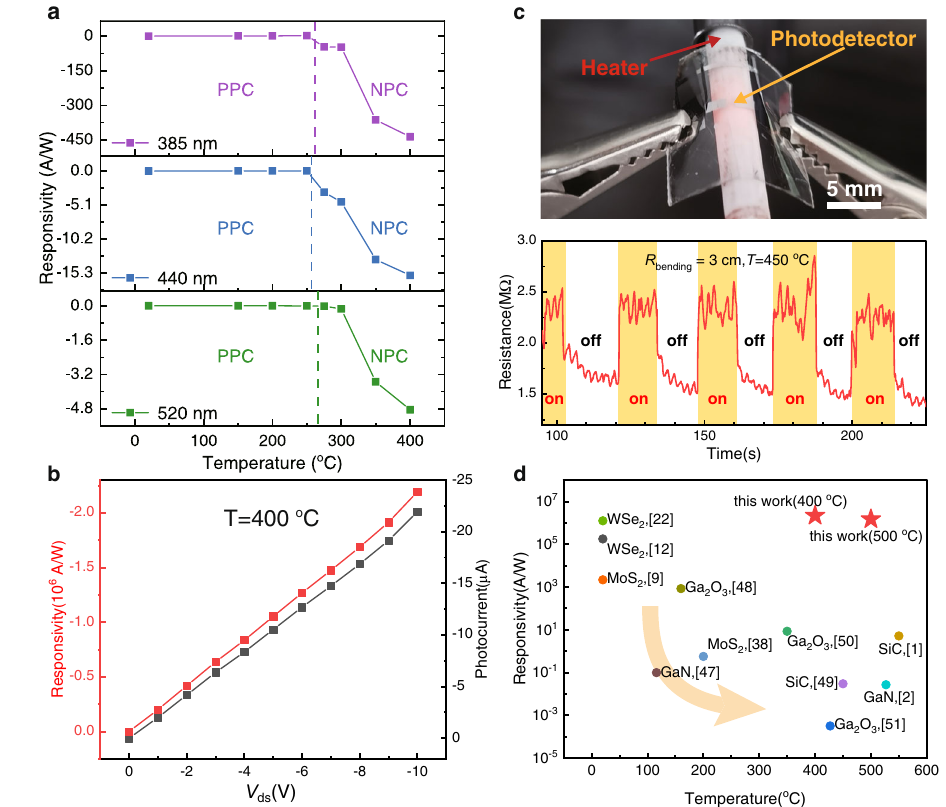
Fig. 5 | High temperature optoelectronic performance. a Responsivity of WSe 2 photodetector under 385nm, 440nm, and 520nm wavelength illumination at dif- ferent temperatures ( V gs =0). Purple (385nm light), blue (440nm light), green (520nm light) dashed lines are used to indicate the switch temperature of PPCand NPC phenomenon. b Responsivity as a function of V ds derived from a typical WSe 2